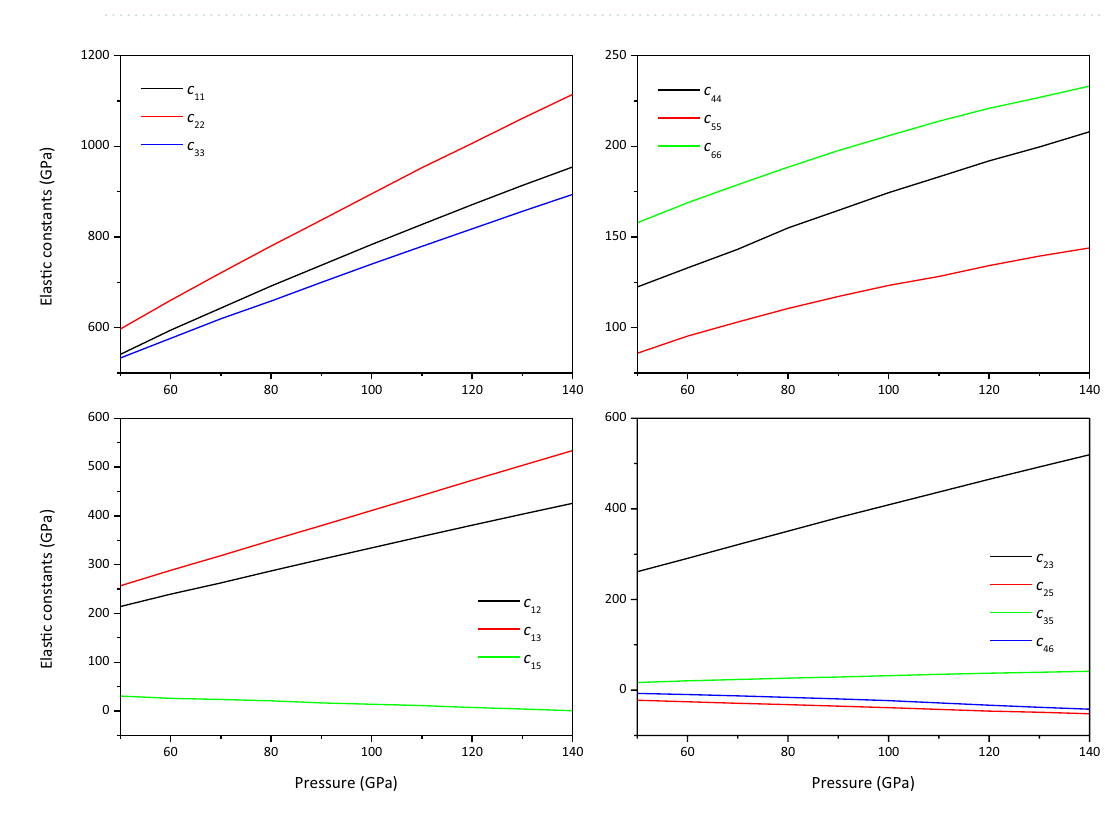
Figure 5. Elastic constants of Mg 2 CO 4 - P 2 1